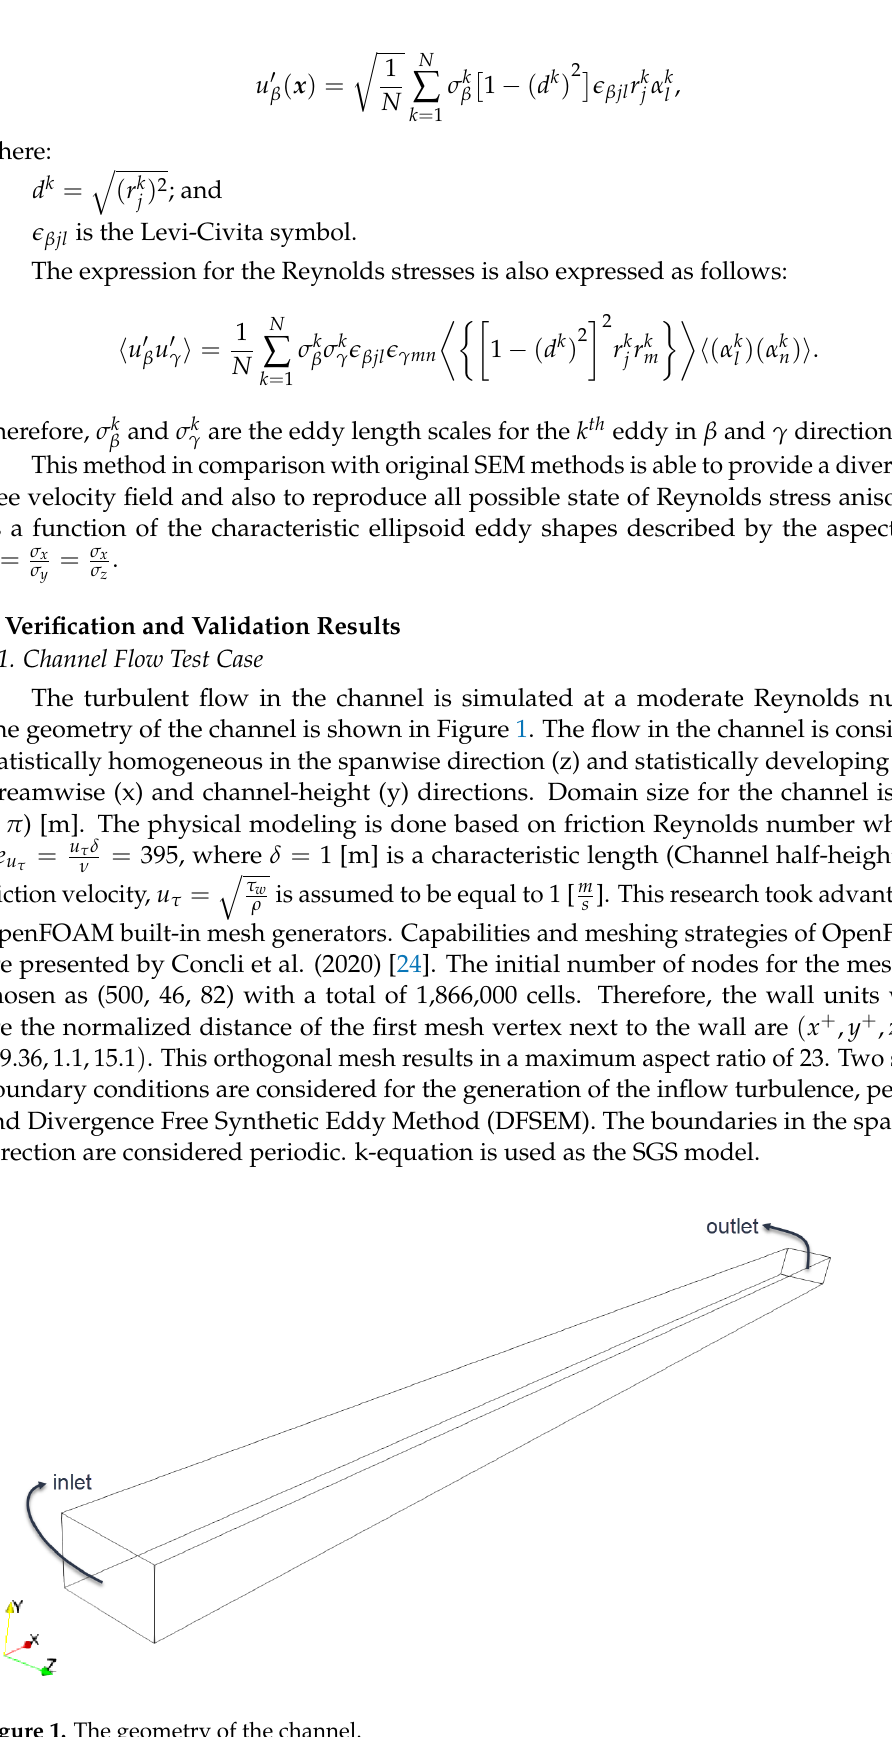
Figure 1. The geometry of the